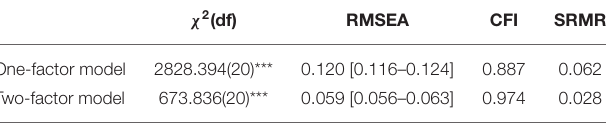
TABLE 1 | Model fit of competing measurement models.